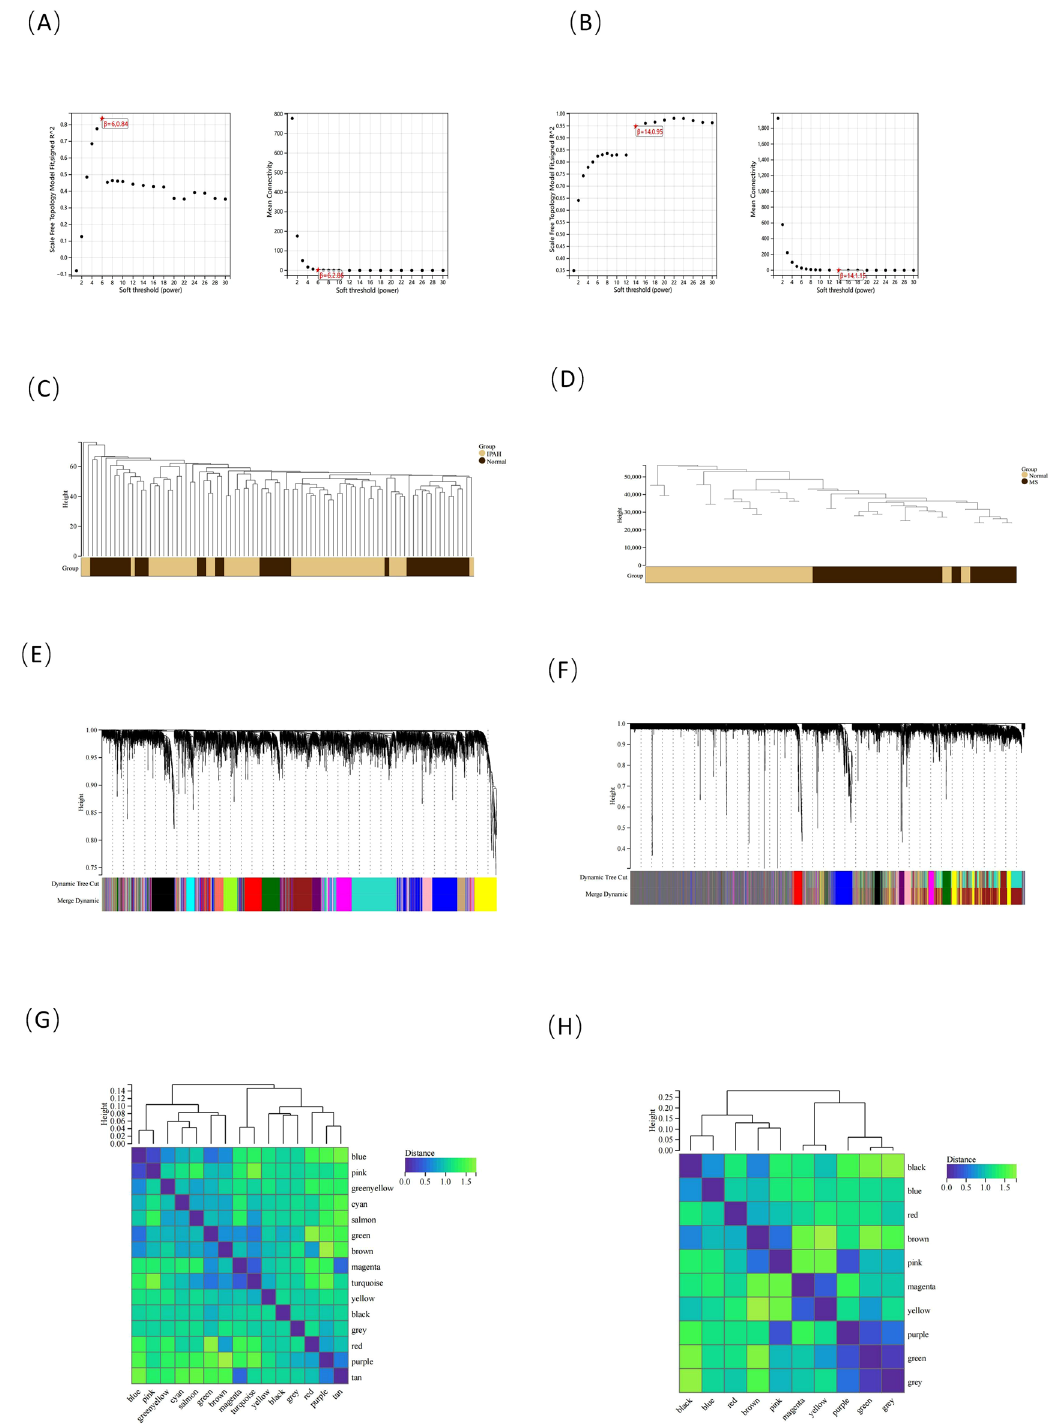
Figure 3. WGCNA in IPAH and MS. Drawn by R software program (version 3.40.6; R Foundation for Statistical Computing, Vienna, Austria, https:// www.r- proje ct. org/). ( A ) Analysis of scale independence and average connectivity in IPAH, select soft threshold β = 6. ( B ) Analysis of scale independence and average connectivity in MS, select soft threshold β = 14. ( C,D ) Sample clustering based on the expression level of patients in the IPAH/MS dataset. Outlier samples have been filtered. ( E,F ) Under the clustering tree, gene co-expression modules represented by different colors. ( G,H ) IPAH/MS Module feature vector clustering